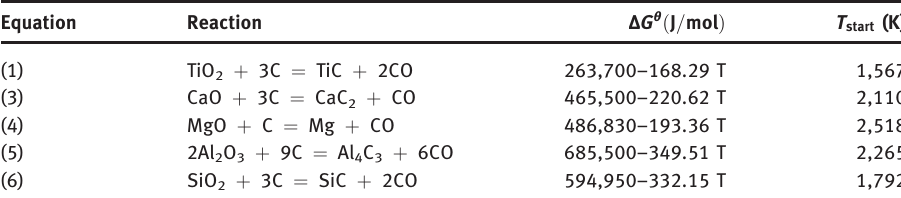
Table 2: Results of the thermodynamics calculation by FactSage6.0. Equation Reaction